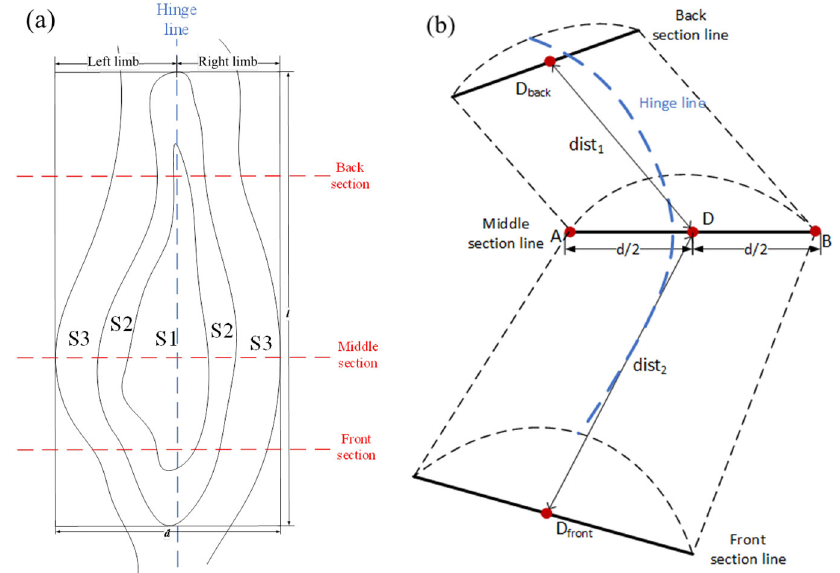
Figure 3. Determination of cross ‐ section locations: ( a ) extraction of location parameters based on a geological map and ( b ) location of sections based on location parameters. S1 ‐ S3 are different stratum geological map and ( b ) location of sections based on location parameters. S1-S3 are different stratum codes.